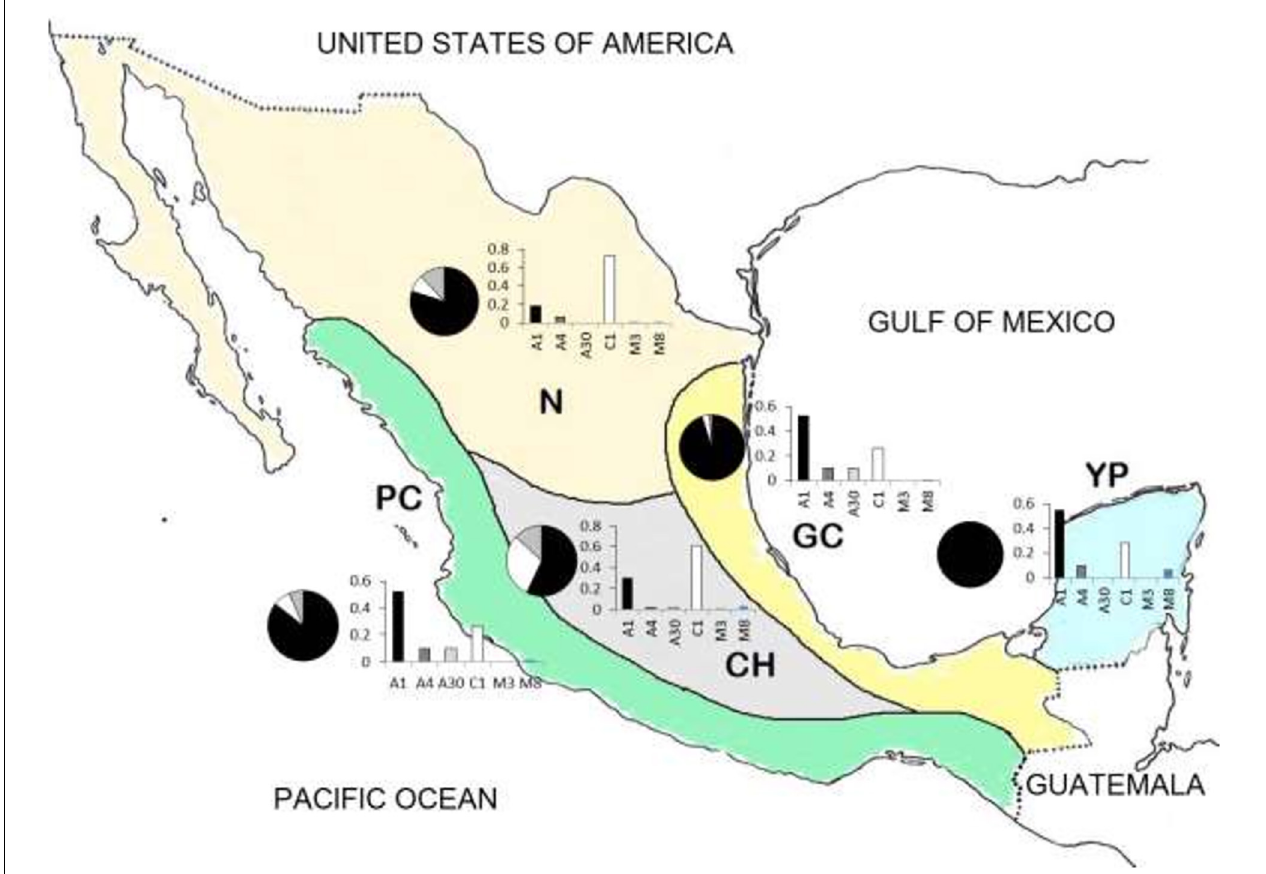
FIGURE 1 | Map of Mexico showing the five main beekeeping regions of the country: North (N), Central highlands (CH), Pacific coast (PC), Gulf coast (GC), and Yucatan Peninsula (YP). The relative frequencies of mitotypes (bar graphs) and morphotypes (pie graphs) in each region show African in black, European in white and intermediate in gray. Letters refer to three different mitotypes of A. mellifera , namely, African (A), West-European (M), and East-European (C) (data from Domínguez-Ayala et al.,